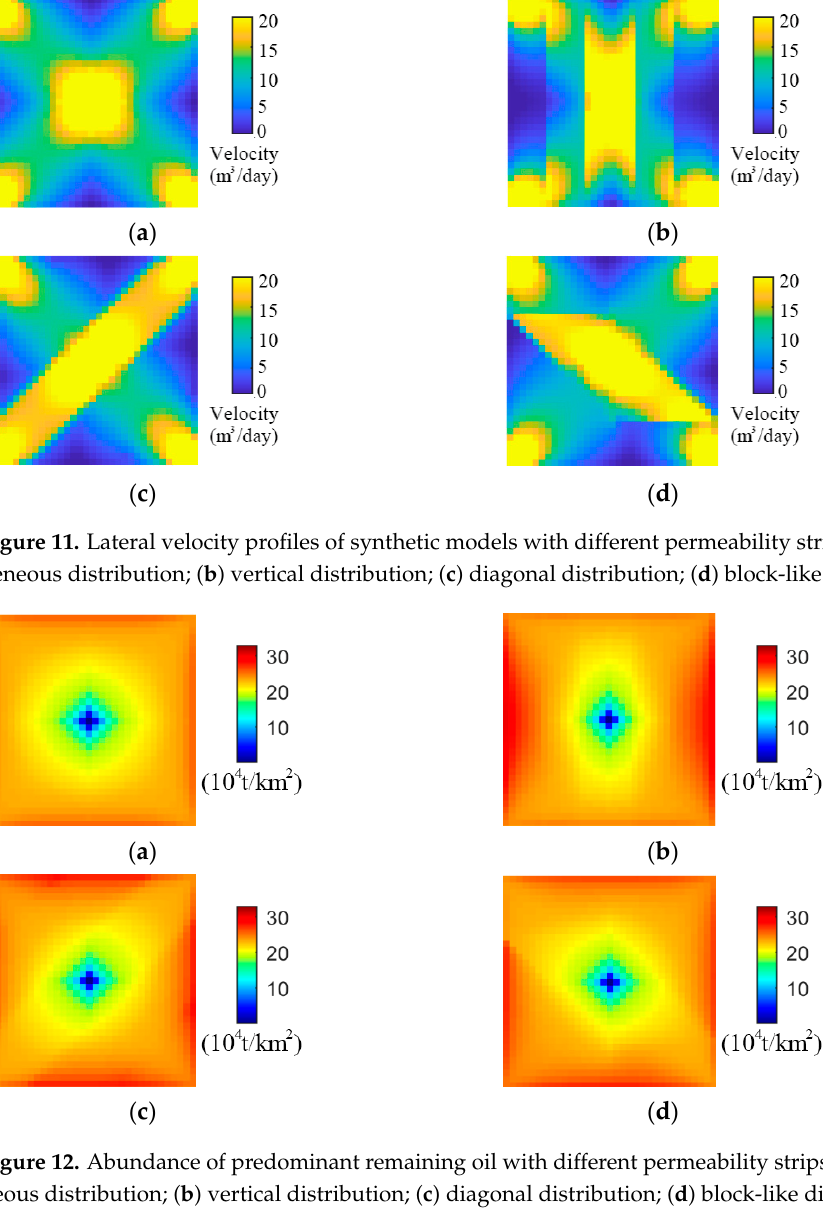
Figure 12. Abundance of predominant remaining oil with different permeability strips. ( a ) Homo- geneous distribution; ( b ) vertical distribution; ( c ) diagonal distribution; ( d ) block-like distribution.